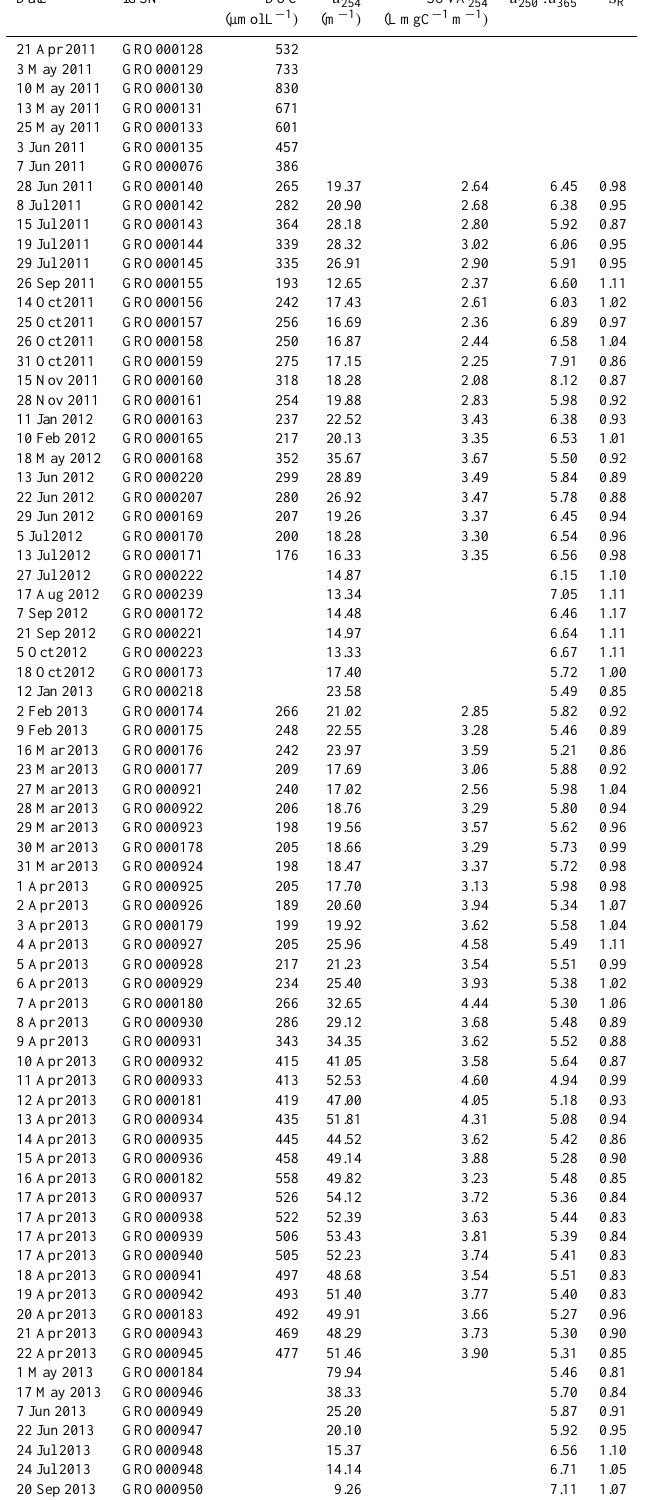
Table 2. Two-year record of DOC concentration and optical properties of the Fraser River main stem at Fort Langley. Sampling in 2012 was not at sufficiently high frequency to capture the freshet pulse of DOC. IGSN codes refer to International GeoSample Numbers in the System for Earth Sample Registration (SESAR) database; sample metadata can be accessed at